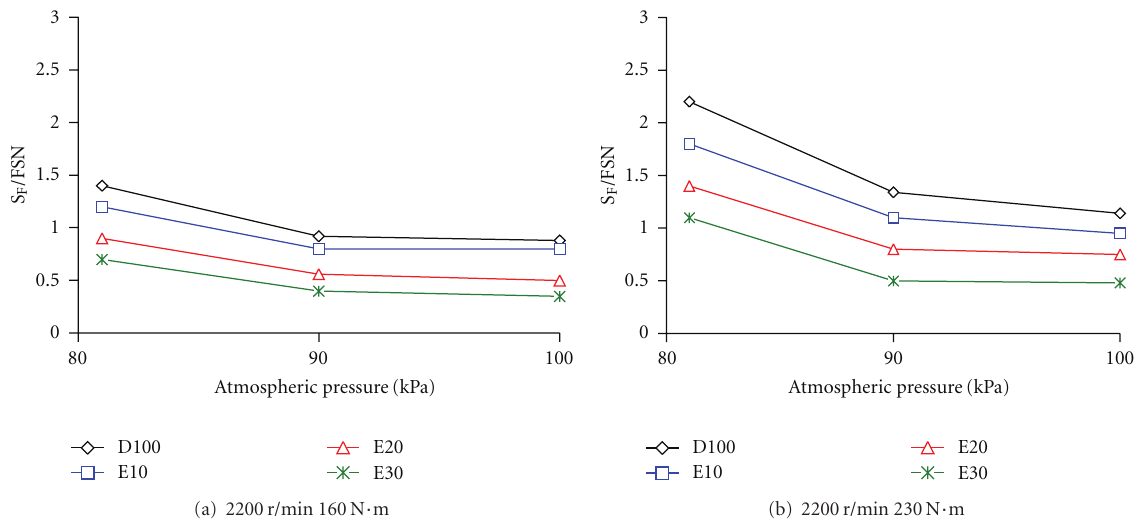
Figure 12: Comparison of smoke of di ff erent atmospheric pressure and mix proportion at speed 2200